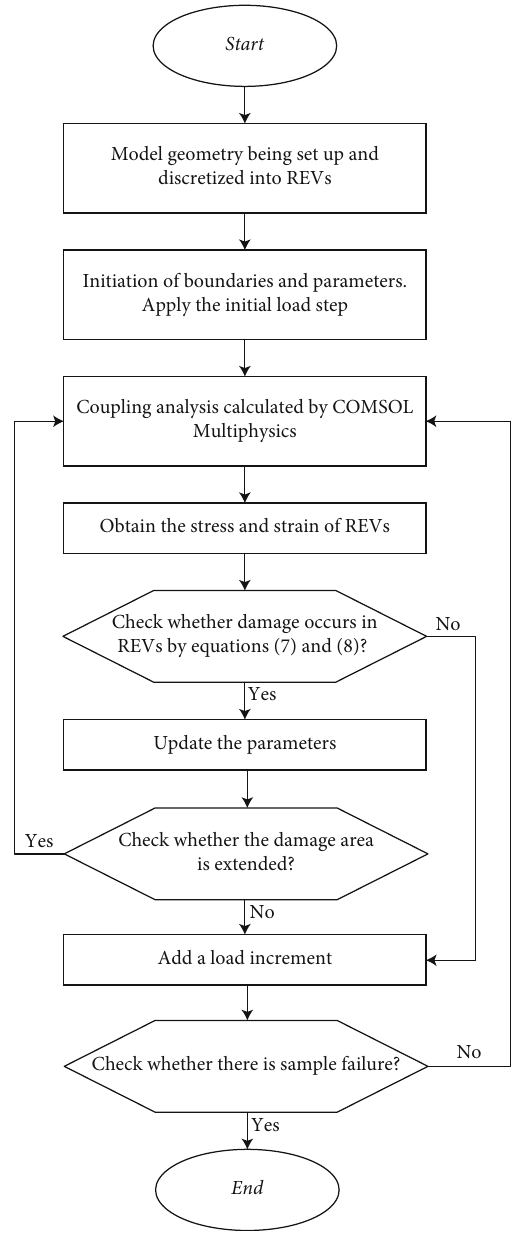
Figure 3: Primary solution procedures for the numerical model.